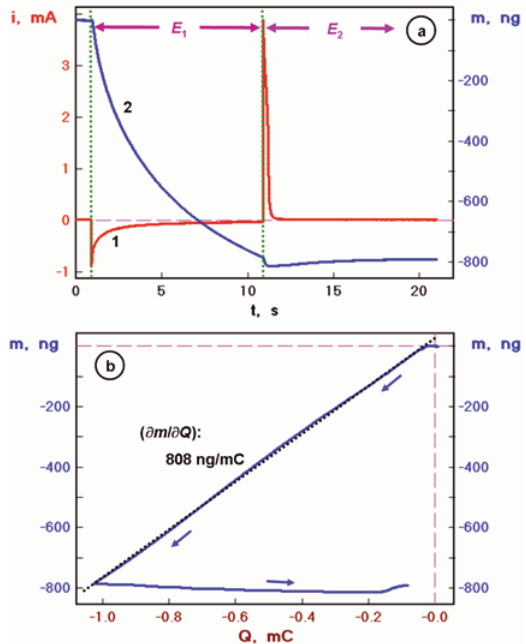
Figure 2. Electroreduction of a WO 10 mM TEAC: (a) current (1) and mass change (2) responses to potential steps: E (b) comparison of mass change and charge transients; (c) m-Q plot.